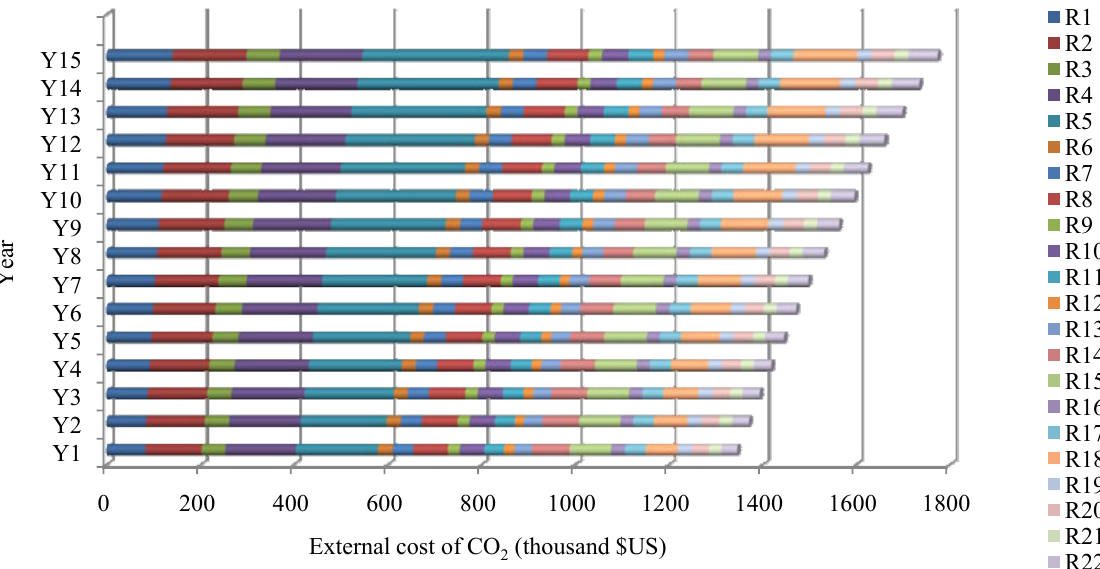
Fig. 3: External cost of CO